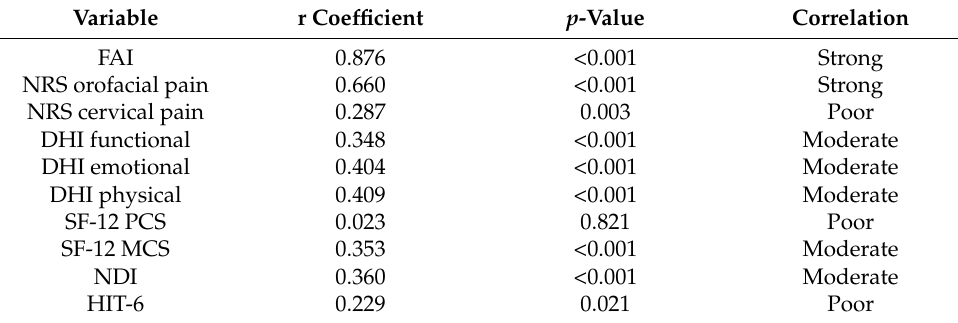
Table 6. R coefficient between SFAI and other variables.